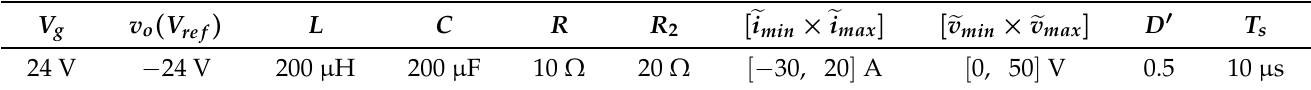
Table 1. Buck-Boost converter parameters.